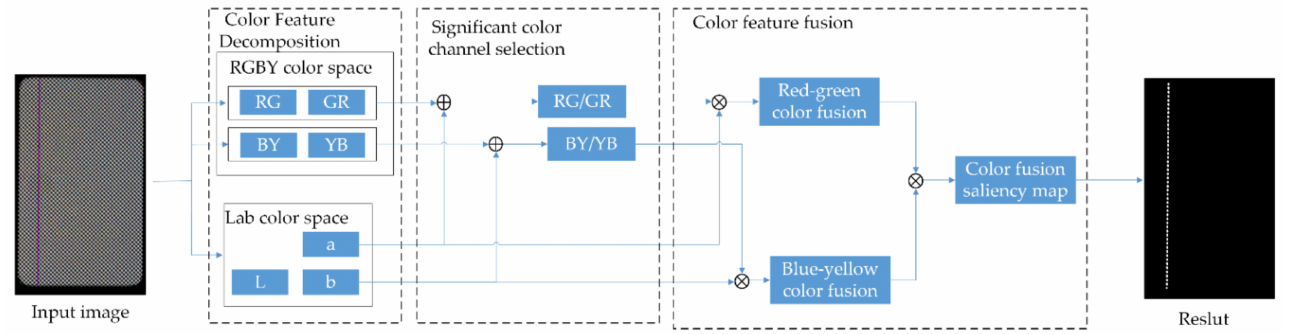
Figure 1. Algorithm